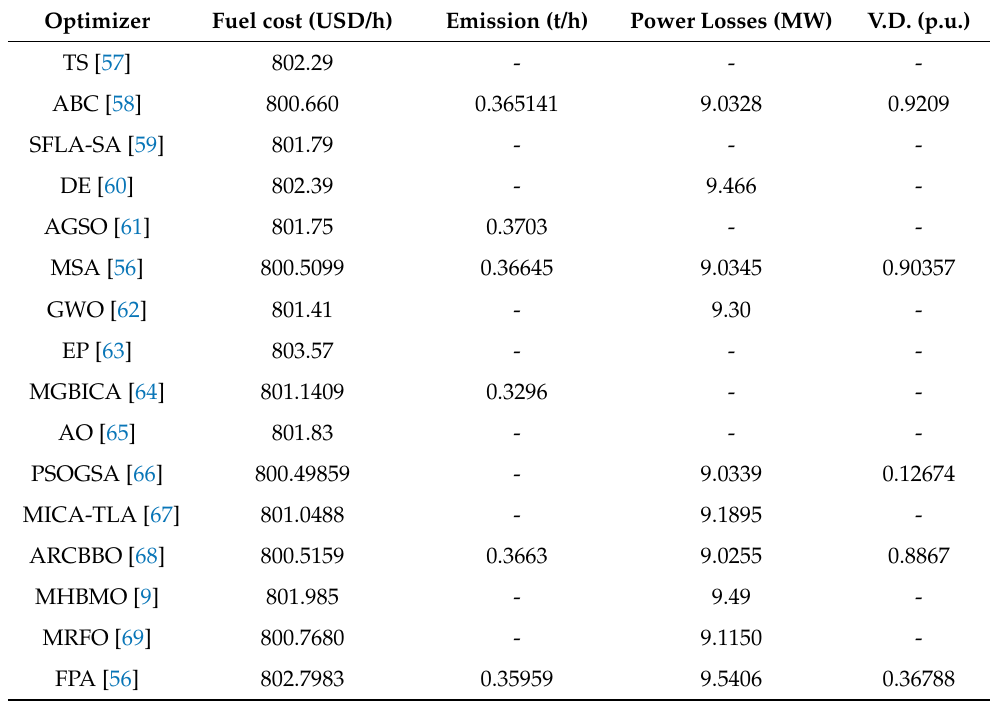
Table 4. Optimal results of the current research in Case